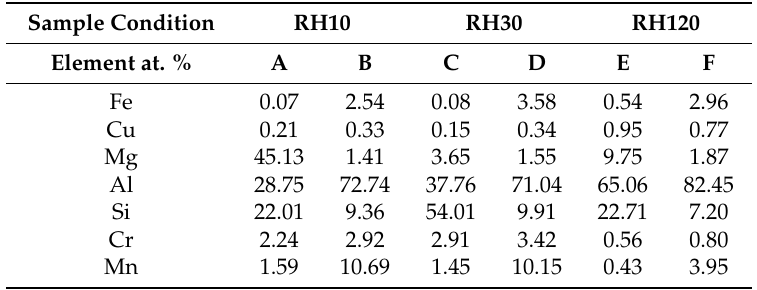
Table 3. Energy-dispersive X-ray spectrometry analysis results for RH-heated specimens. Sample Condition RH10 RH30